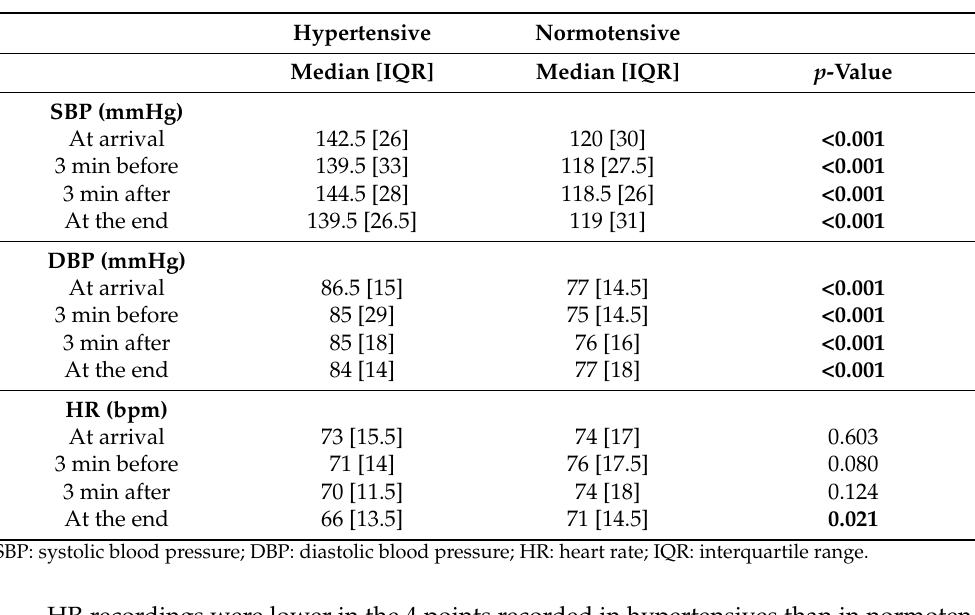
Table 2. Values of SBP, DBP, and HR for the hypertensive ( n = 48) and normotensive ( n = 152) groups.